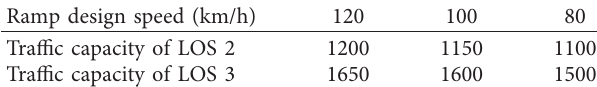
Table 2: Expressway single-lane service traffic volume.